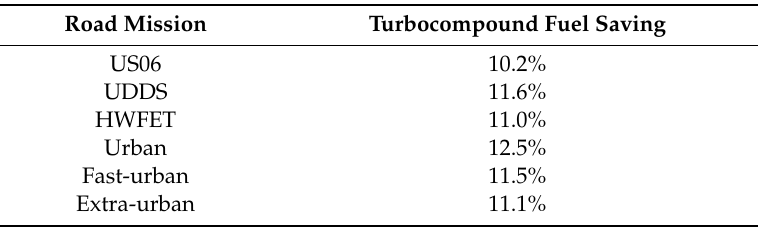
Table 8. Turbocompound fuel